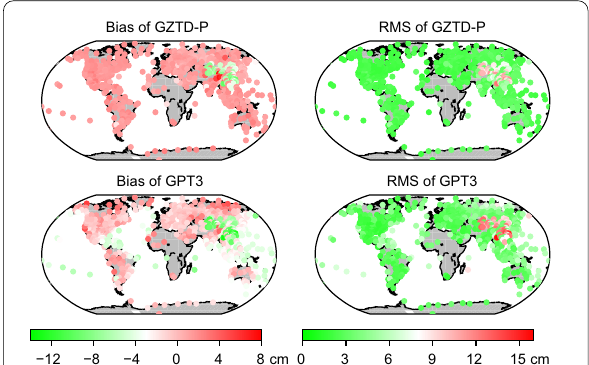
Fig. 3 The bias and RMS of GZTD-P model and GPT3 model validated at radiosonde stations